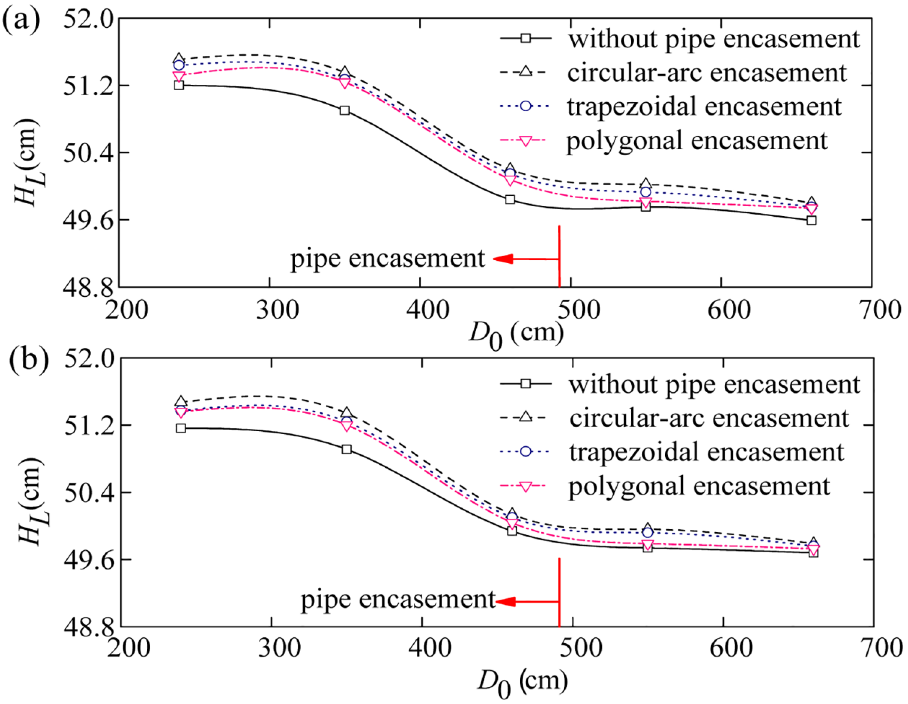
Fig 6. Water level curves on the left bank (a) and the right bank (b) for a 50-year flood event. Table 2 compares the cross-section averaged flow velocities ( v ) of CS1-CS4 measured before and after the pipe encasements are installed. Compared to the natural fl ow of Phase IV, the v